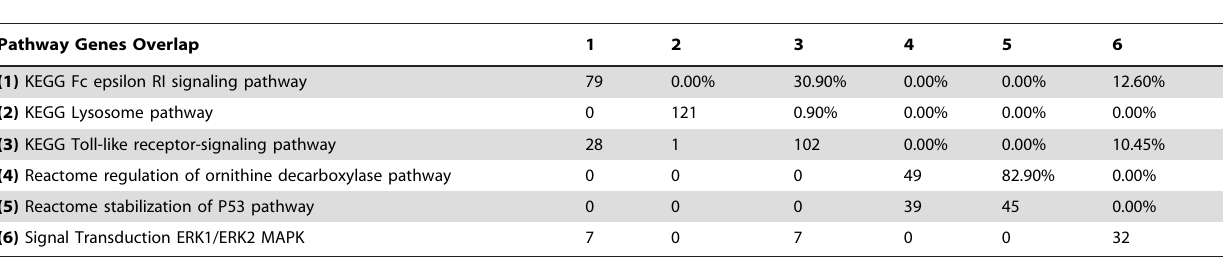
Table 3. Genes shared by significant